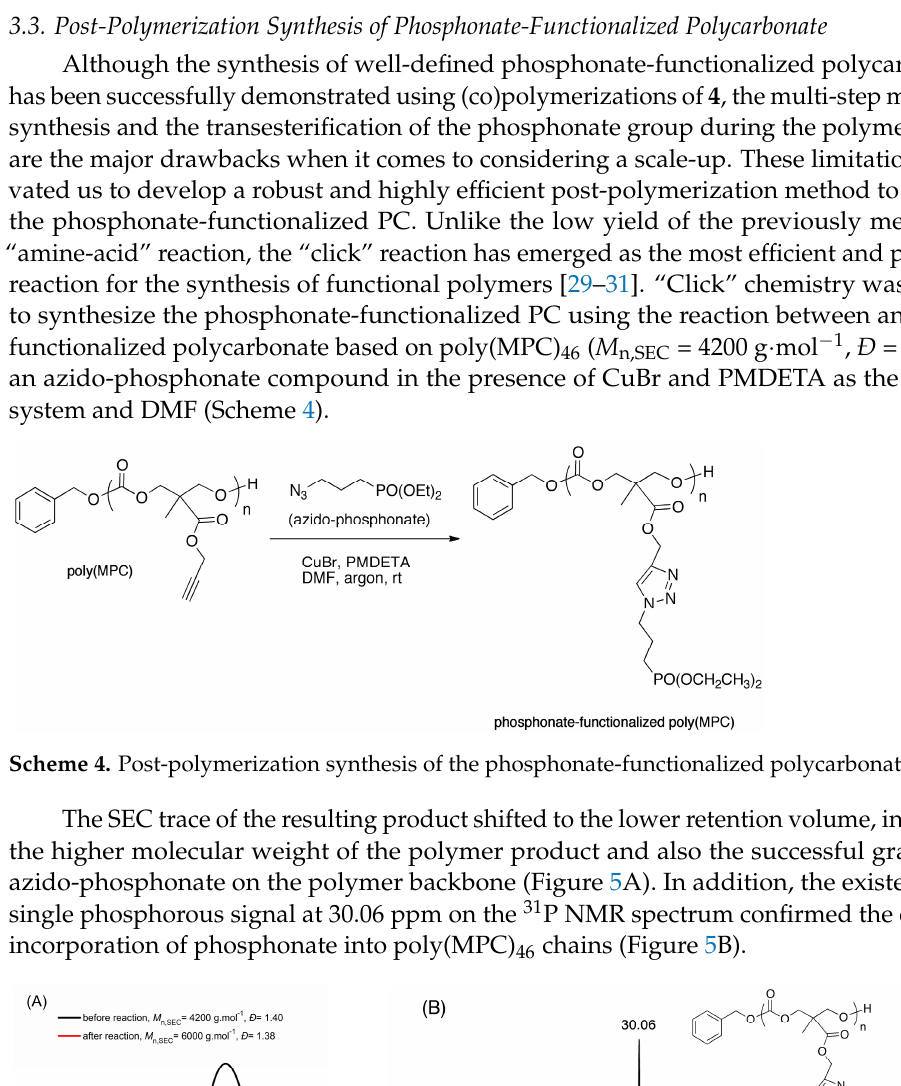
Figure 4. Overlaid 1 H ( bottom ) and 31 P NMR ( top-right corner ) spectra of phosphonate-functional- ized poly[( 4 ) 21 - co -MPC 21 ] copolymer in CDCl 3 .